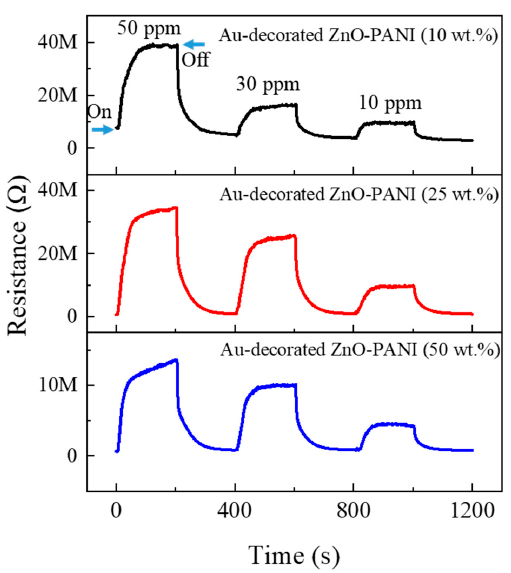
Figure 7. Dynamic resistance graphs of the Au-decorated ZnO-PANI (10, 25, and 50 wt.%) composite nanofiber sensors to 10, 30, and 50 ppm NO 2 gas at 300 ◦ C. For a better comparison, we depicted the calibration curves of different gas sensors in Figure 8a,c for the sensors with 10, 25, and 50 wt.% PANI, respectively. In all cases, the responses increased with increasing NO 2 gas concentration. In addition, the response showed an almost linear dependence on the NO 2 gas concentration. Figure 8d summarizes the responses of all sensors with different amounts of PANI at various concentrations of NO 2 gas. The sensor with 25 wt.% PANI indicated the highest response to NO 2 gas; therefore, it was selected for further gas sensing studies. Moreover, the sensor with 50 wt.% PANI showed a higher response relative to the sensor with the lowest amount of PANI (10 wt. %).